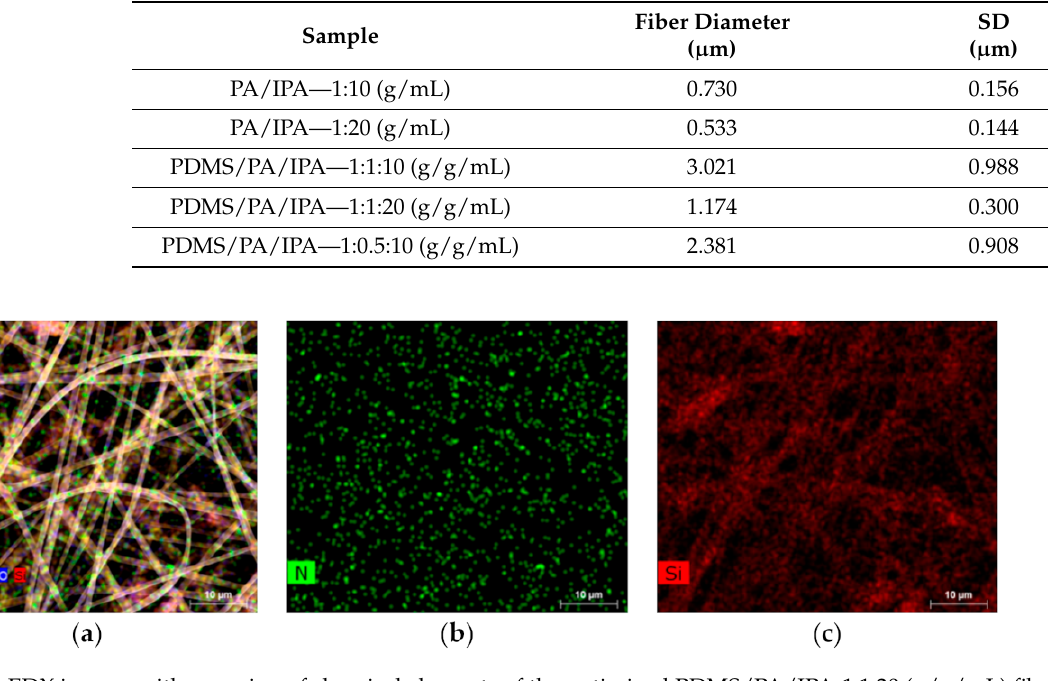
Figure 3. SEM-EDX images with mapping of chemical elements of the optimized PDMS/PA/IPA-1:1:20 (g/g/mL) fiber mats: ( a ) C, O, N, Si, ( b ) N, ( c )